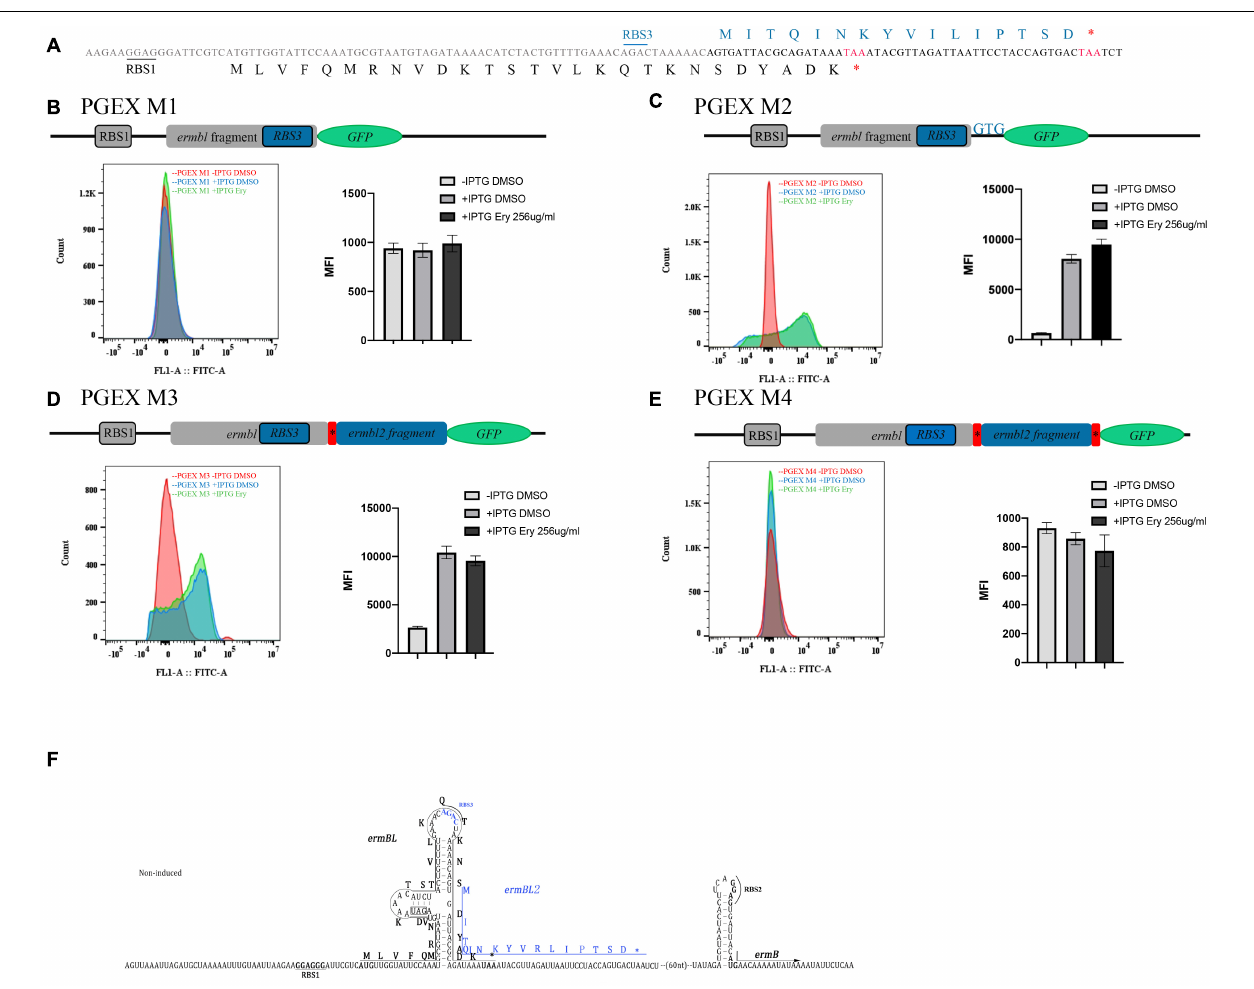
FIGURE 5 | Complete sequence information of new leader peptide named ermBL2. (A) The detailed sequence of ermBL and predicted new leader peptide. (B) The structure of PGEX M1. The fusion contains the predicted RBS3, but does not have the predicted start codon. GFP (without its own start codon) is not expressed with ermBL, as ermBL and GFP have (+1) frameshifts. Flow cytometry of GFP intensity is shown. (C) The structure of PGEX M2. The fusion contains both the predicted RBS3 and predicted start codon. (D) The structure of PGEX M3. The fusion contains the predicted RBS3, predicted start codon, and full length of predicted ermBL2 except the TAA codon. (E) The structure of PGEX M4. The fusion contains the predicted RBS3, predicted start codon, and full length of predicted ermBL2 including the TAA codon. (F) Model of the ermB regulatory region, including two leader peptides. Data are mean ± SEM from three independent experiments (unpaired two-tailed Student’s t